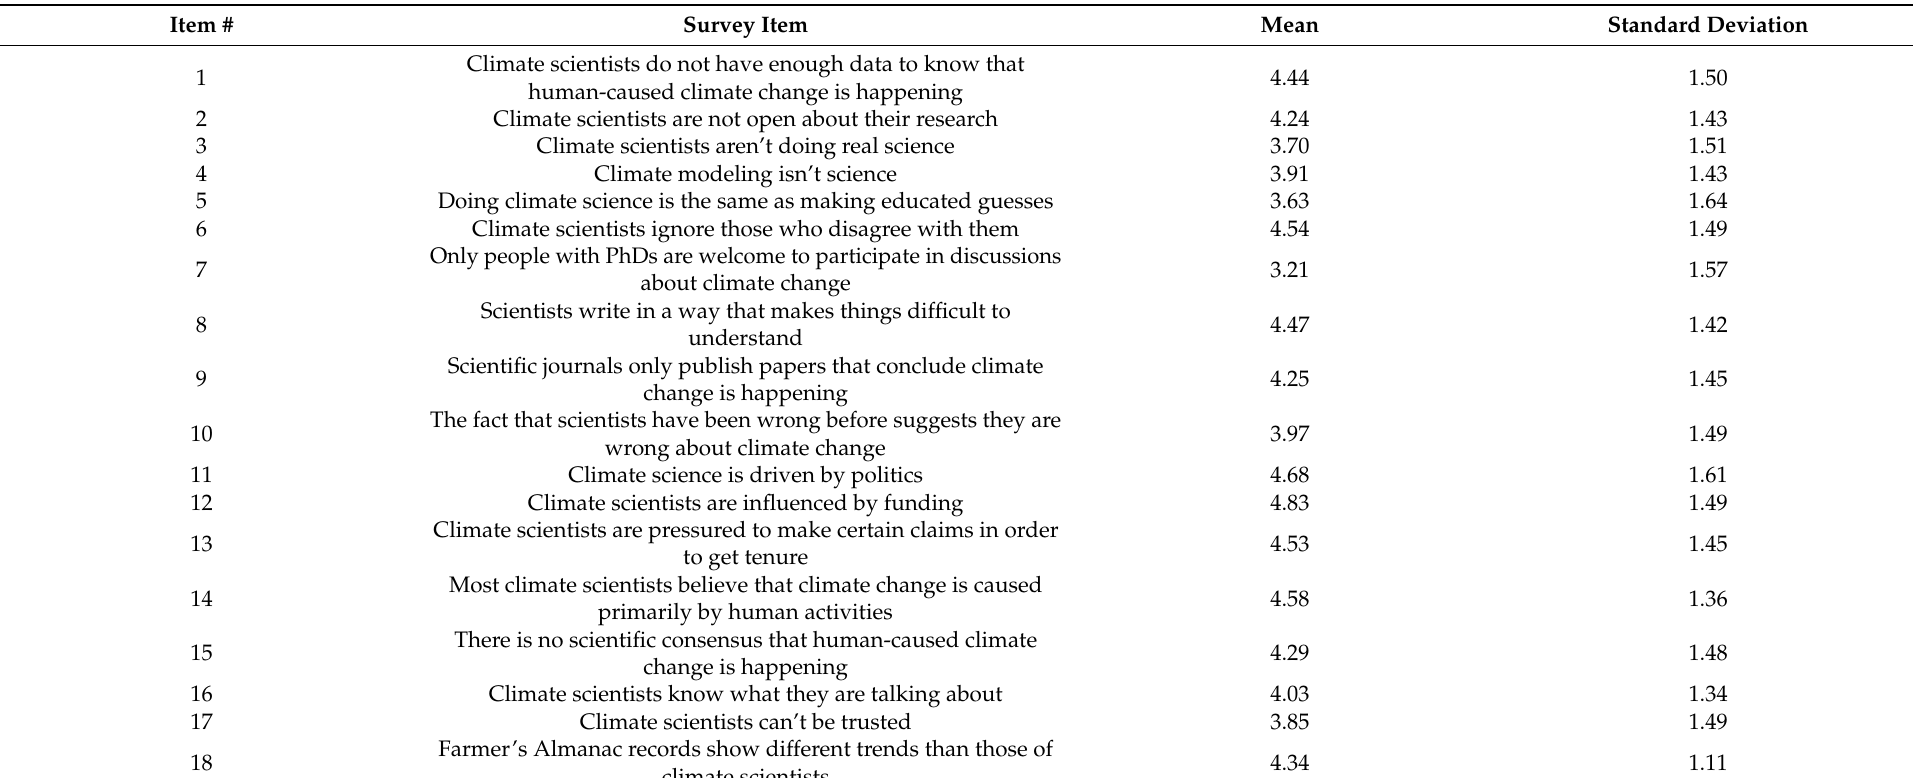
Table 1. Full list of survey items on skeptics’ (dis)trust in climate